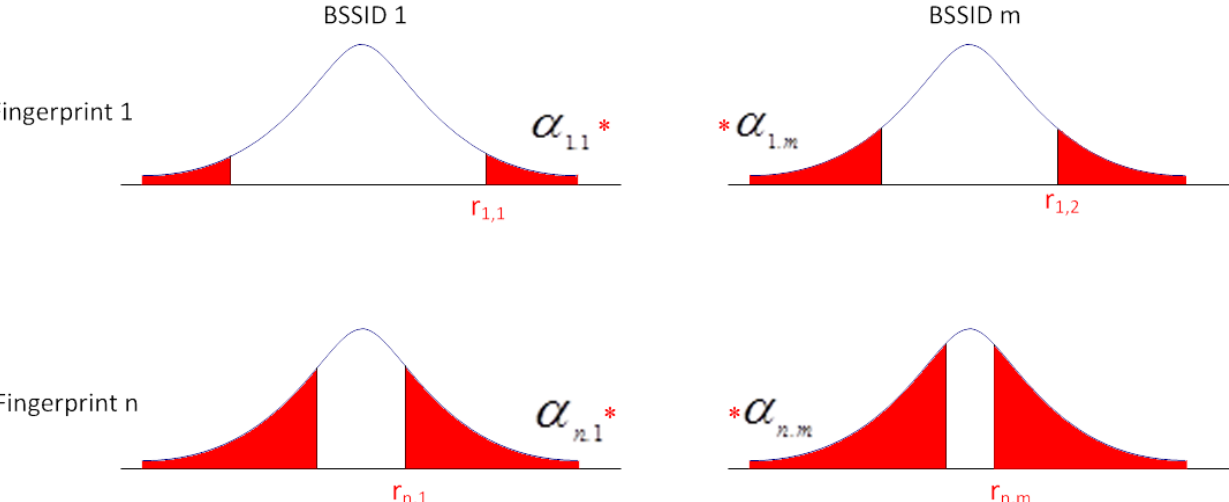
Figure 4. Process of calculating the likelihood of different